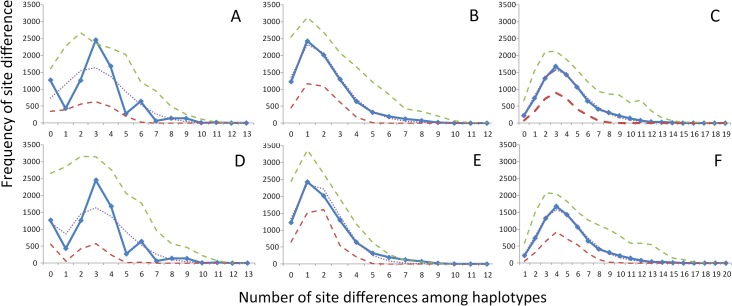
Mismatch distributions of mtDNA haplotypes from pooled Gulf of Mexico samples.
A-C show results from fitting data to a pure demographic expansion model and D-F show results from fitting data to spatial expansion model. A and D are derived from sequence information only, B and E are derived from indel information only, and C and F are derived from both data-types combined. The demographic expansion model was only rejected for A. In all other case, demographic and spatial expansion models were not rejected. Solid line represents observed data; dotted line represents model prediction; dashed line represent 95% confidence interval for model prediction.